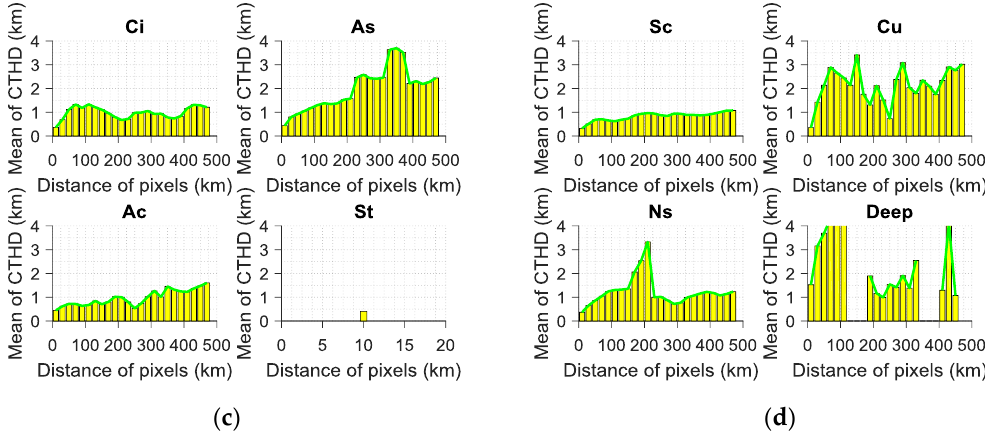
Figure 10. SDs ( a , b ) and mean values ( c , d ) of CTHD, along with the distance between recipient and donor pixels in May 2015, in the region 0~60° N and 70–140° E, where ( a , c ) are for Ci, As, Ac, and St, and ( b , d ) are for Sc, Cu, Ns, and Deep.